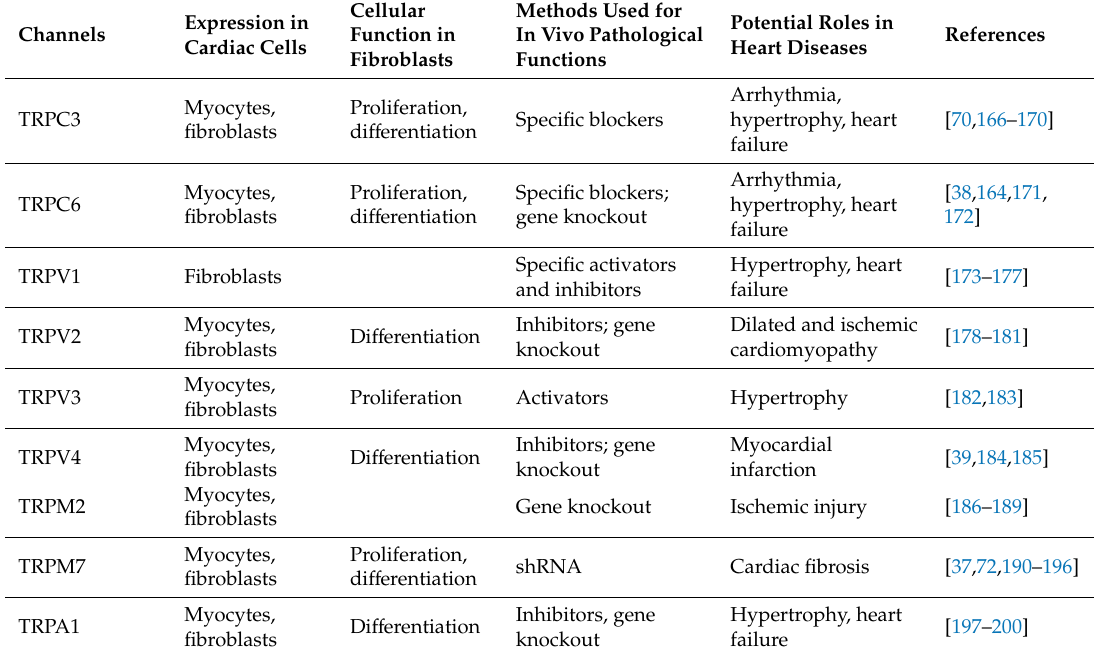
Potential Roles in Heart